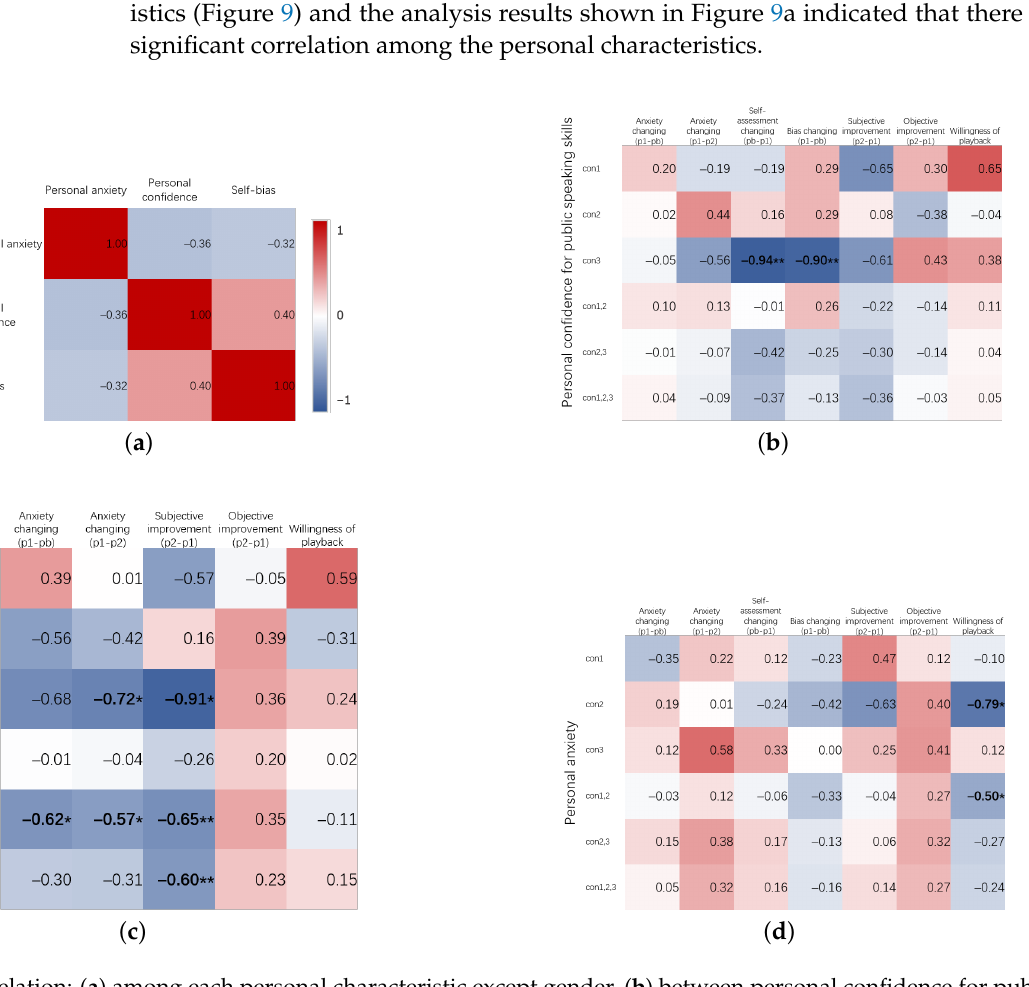
Figure 9. Correlation: ( a ) among each personal characteristic except gender, ( b ) between personal confidence for public speaking skills and training indicators as well as Wil, ( c ) between self-bias and training indicators as well as Wil, ( d ) between personal anxiety for public speaking and training indicators as well as Wil. ∗∗ indicates p < 0.01. ∗ indicates p <